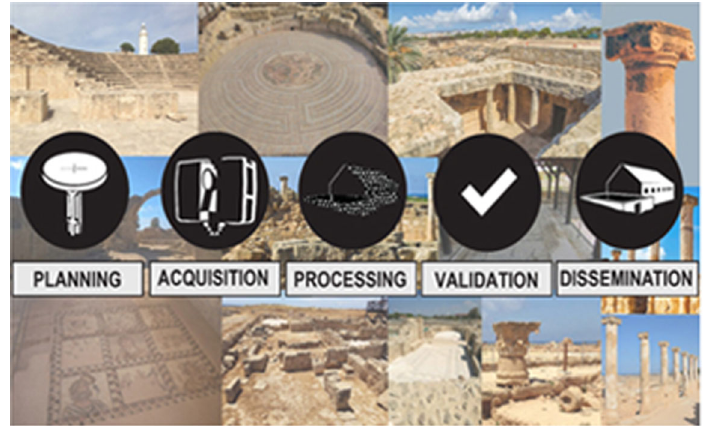
Fig. 10 The digital workflow for digital documentation. On the background some images of the Paphos archaeological park (Source: the